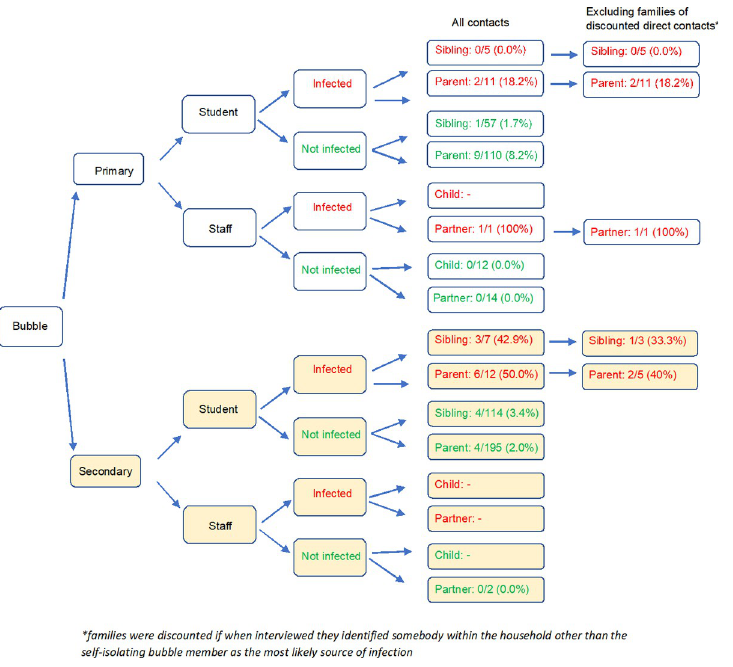
Fig 1. Flow diagram showing the secondary attack rates of indirect